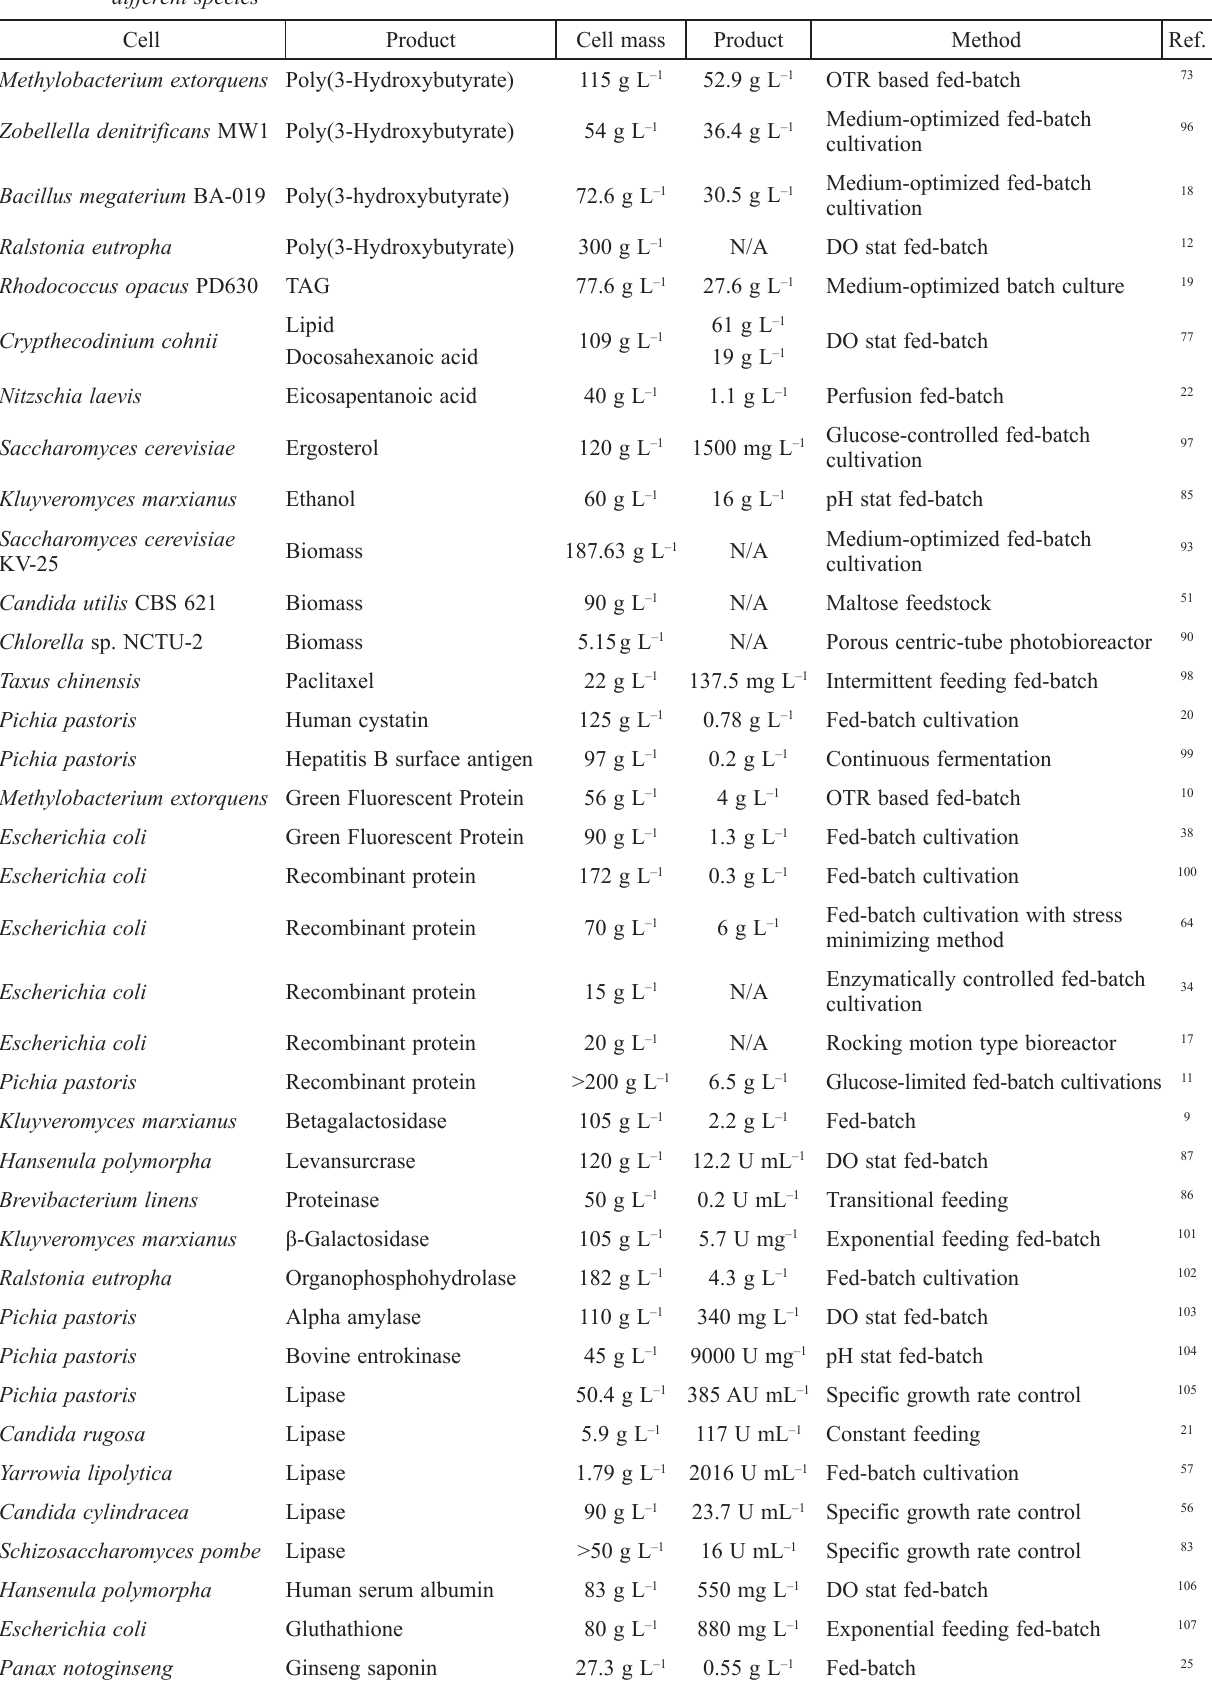
Table 1 – High-density cultivations adopted for different product formations: The maximum cell mass and product obtained from different species Cell Product Cell mass Product Method